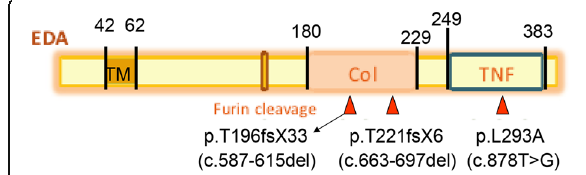
Fig. 2 The locations of three unknown EDA gene mutation sites in the functional domain of the EDA gene. Notes: EDA, ectodysplasin A; TM, transmembrane domain; Furin cleavage, furin enzyme binding site; Col, collagen-like domain